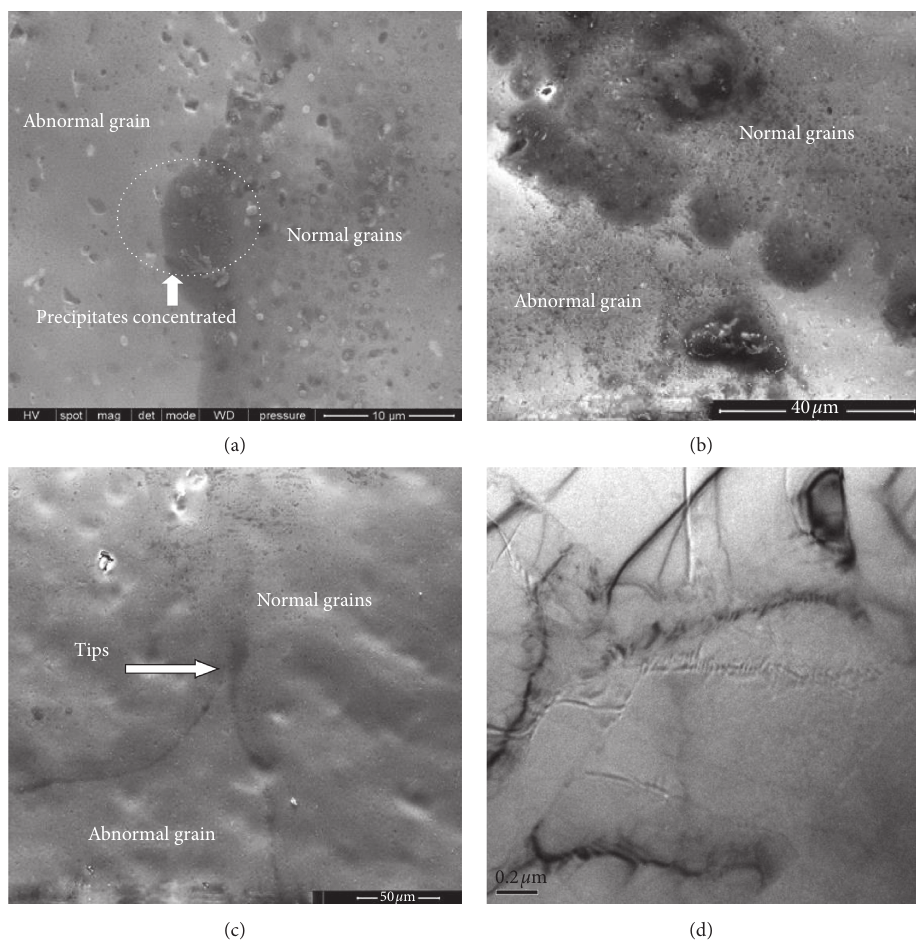
Figure 6: Growth penetrating into the semidissolved Fe-enriched coarse particles. (a) The dissolution of coarse precipitates leading to bugling of GB. (b) Zigzags at the location with partially dissolved original segregation. (c) Rapid bugling of GB into the location with high content Fe. (d) TEM micrograph of the annealed alloy.